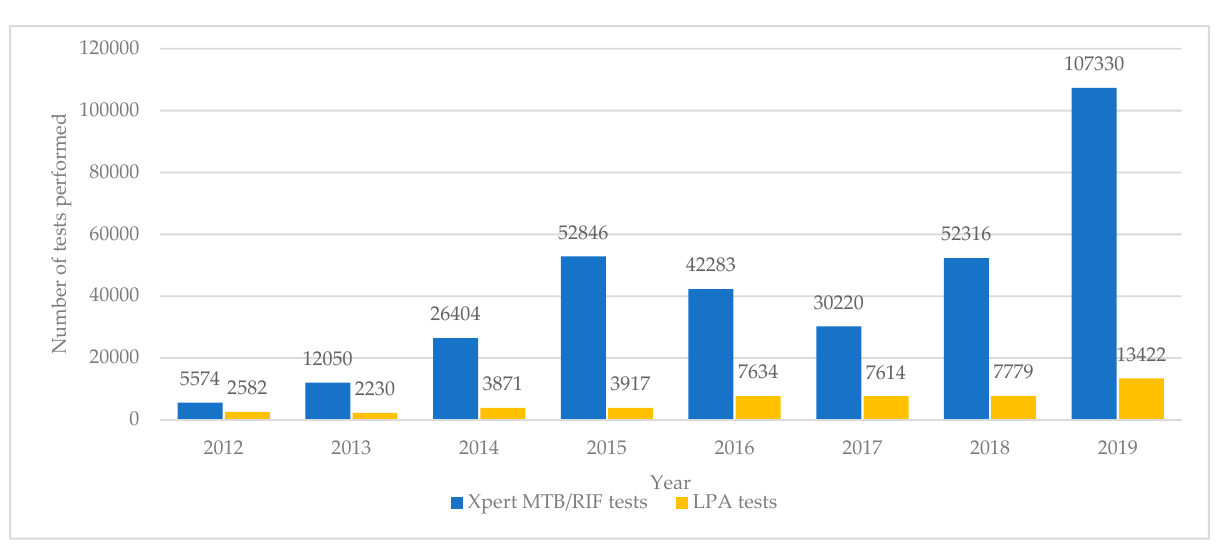
Figure 3. Molecular diagnostic tests (Xpert MTB/RIF and LPA) performed each year in Uzbekistan from 2012 to 2019. LPA = line probe assay.